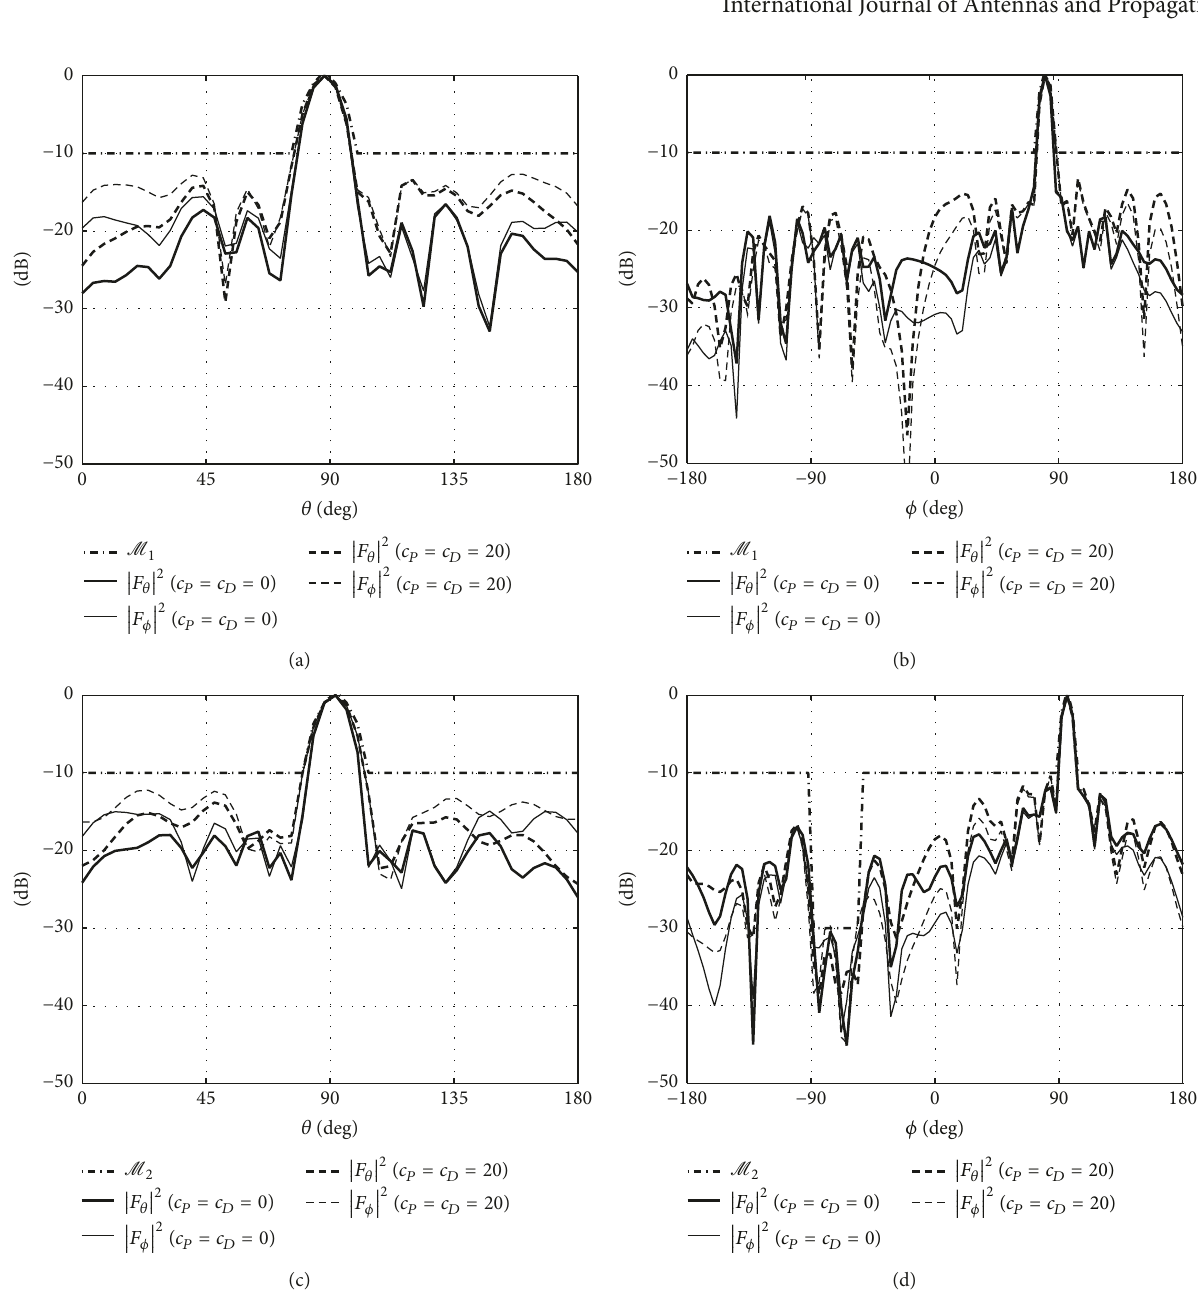
Figure 3: First application, 2D far-fields pattern cuts: (a) 𝑙 = 1 (first pattern), cut at 𝜙 = 80 ∘ , (b) 𝑙 = 1 (first pattern), cut at 𝜃 = 88 ∘ , (c) 𝑙 = 2 (second pattern), cut at 𝜙 = 96 ∘ , and (d) 𝑙 = 2 (second pattern), cut at 𝜃 = 92 ∘